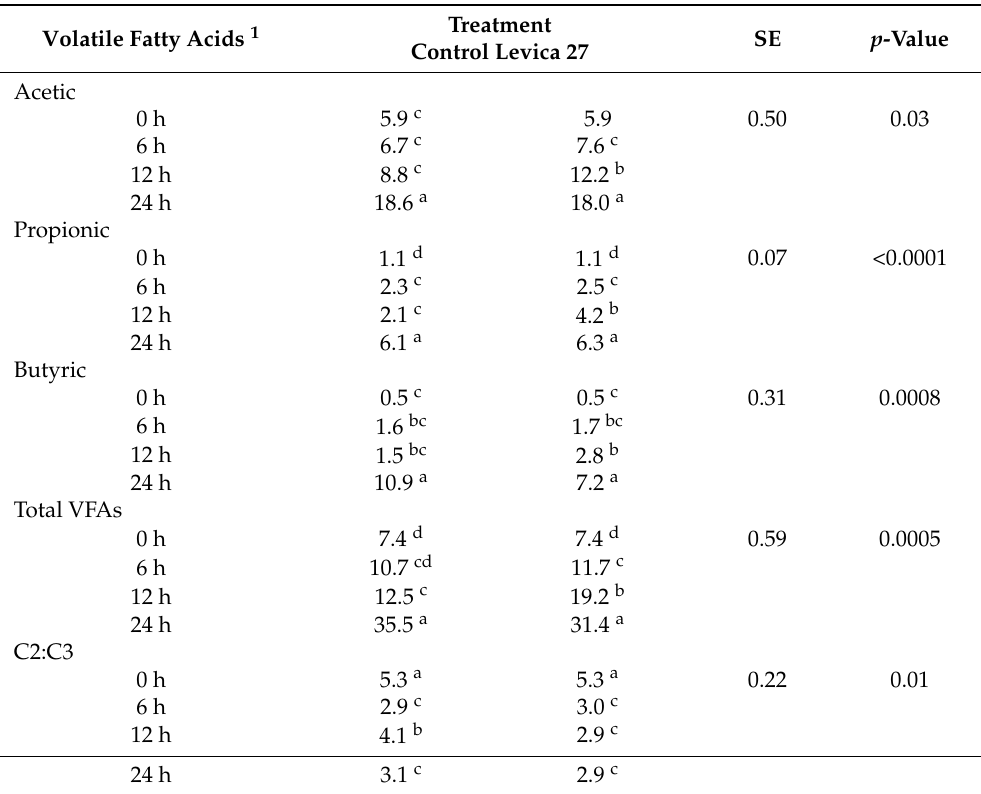
Table 3. Effect of Pichia guilliermondii strain Levica 27 during in vitro ruminal fermentation on the production of volatile fatty